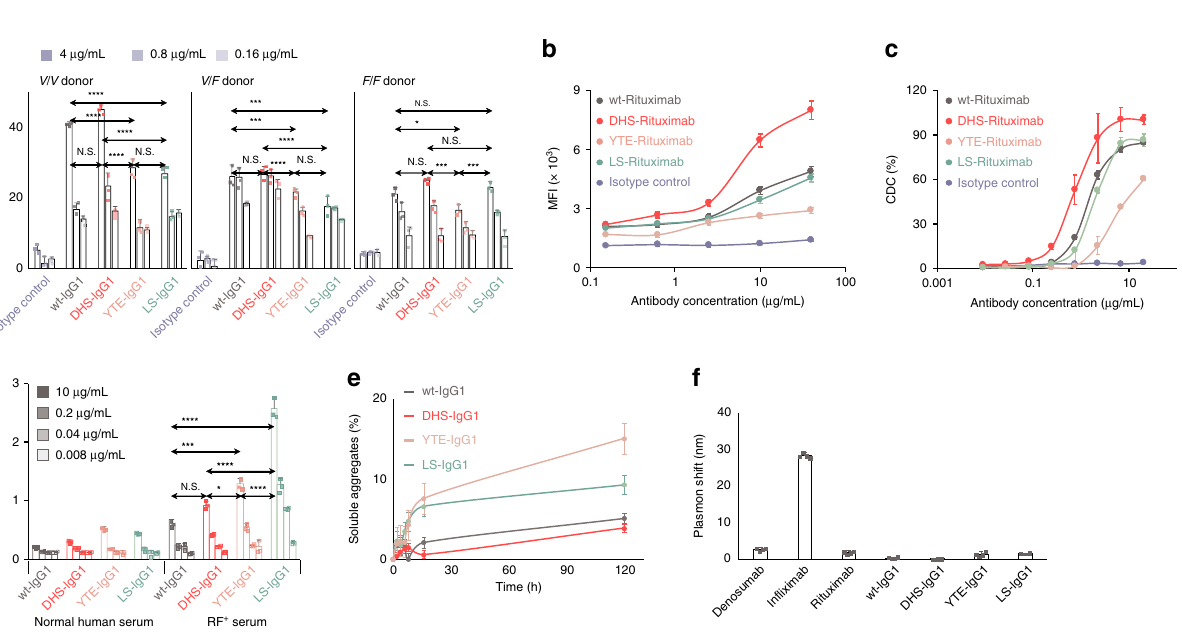
AllIgGvariantsanalyzedwithmonomericFcreceptorsandtheirkineticvalueswereanalyzedbytheequivalentbindingmodel.Dataarepresentedasmean±standarddeviationfromtriplicateexperiments